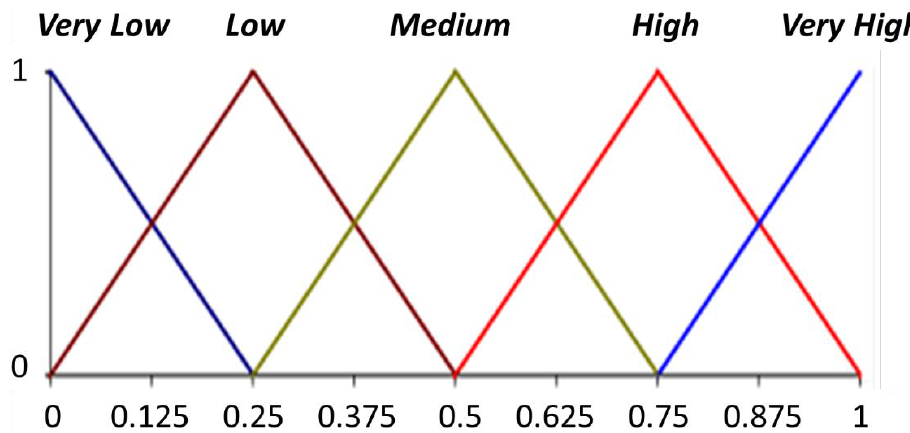
Figure 3. Definition of the set S for the variable “number of passengers”.